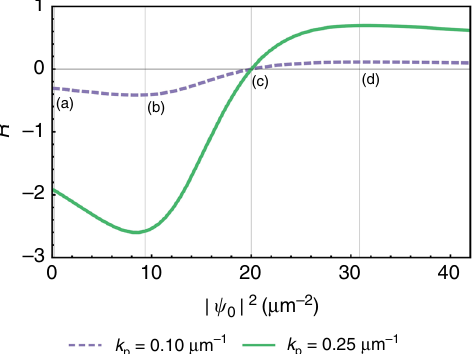
Fig. 5 Response at fi nite detuning. Total long wavelength response for k = 0.1 µ m − 1 (dashed purple) and k = 0.25 µ m − 1 (solid green) normalised p p with respect to the mean- fi eld density, R = m * χ xx ( q → 0 )/| ψ 0 | 2 . Vertical lines marked ( a – d ) correspond to the excitation spectra in Fig. 2. For a and b , the response is negative, and goes to zero close to c where the excitation spectrum is of the linear Bogoliubov form (the mean- fi eld component, Eq. (13), is exactly zero at c on account of an imaginary mean- fi eld, but the fl uctuations are small and fi nite), before becoming positive, peaking around d , and tailing off similarly to the resonant case in Fig. 4. Larger k p leads to a larger response to perturbations. Note that there is no change in response q ffiffiffiffiffiffiffiffiffiffiffiffiffiffiffiffiffiffiffiffiffiffi (cid:7) (cid:7) (cid:7) (cid:7) 2 = m (cid:3) V ψ , which associated with the speed of sound, given by c 0 s ¼ corresponds to the momentum k = 0.1 µ m − 1 when | ψ 0 | 2 = 6.1 µ m − 2 and k = 0.25 µ m − 1 when | ψ 2 = 38.1 µ m − 0 |